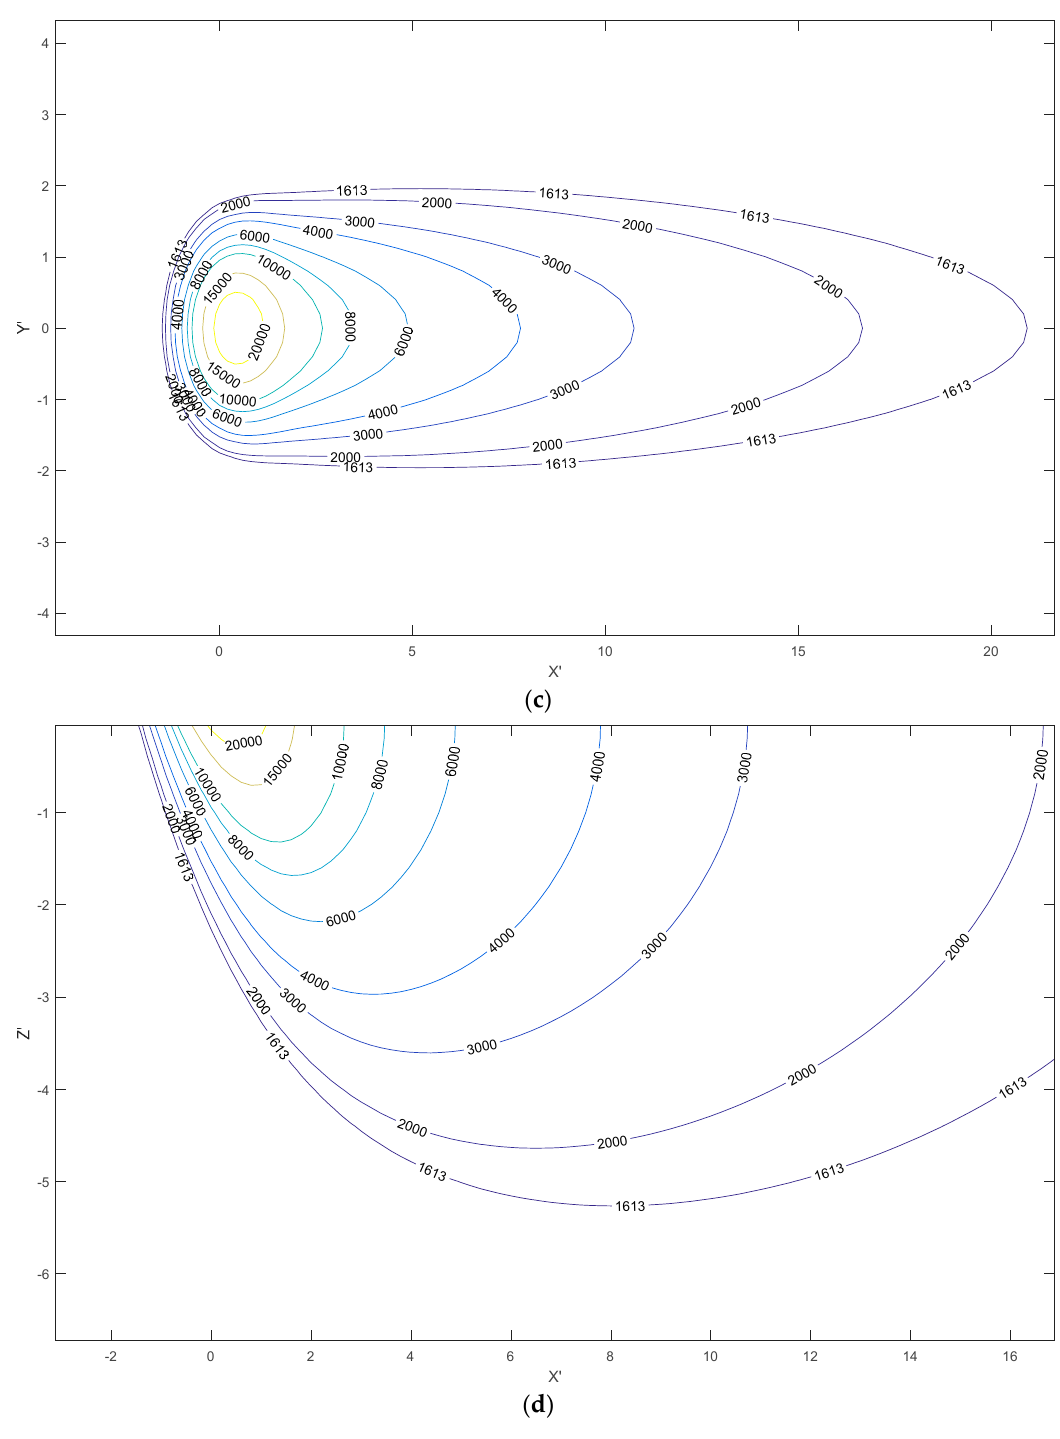
Figure 3. Melt pool temperature contour at top view and longitudinal view for In718 with a laser power of 100 w, scanning speed of 1 mm/s, laser spot radius of 50 μ m and different absorptivity (( a , b ) A = 0.3, ( c , d ) A = 0.87).